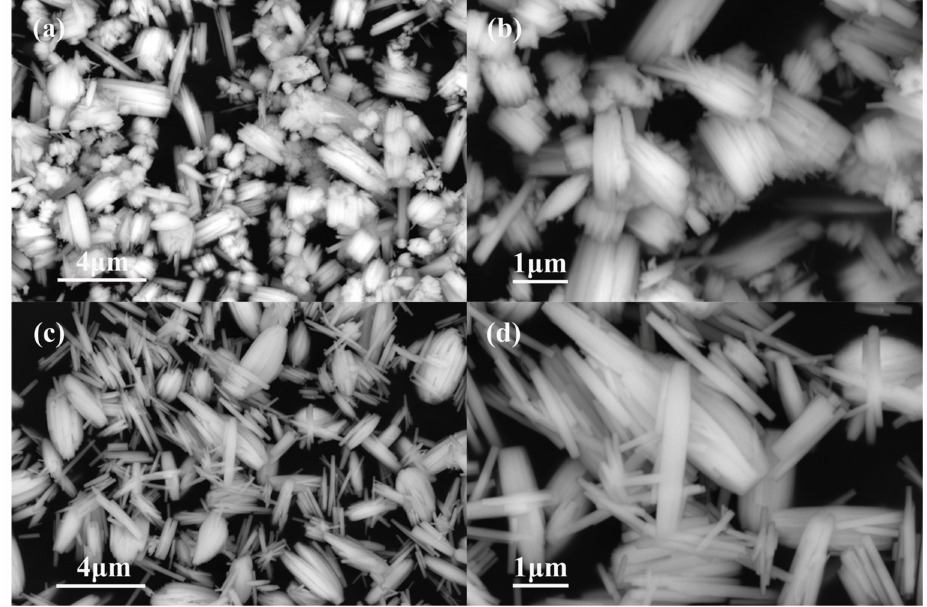
Figure 1. FE-SEM images of the products formed with different initial reactants. ( a , b ) 1.4432 g Na 2 WO 4 2H 2 O, 30 mL 0.25 mol L − 1 H 2 SO 4 ( c , d ) 1.4432 g Na 2 WO 4 2H 2 O, 20 mL 0.375 mol L − 1 H 2 SO 4 , and 10 mL